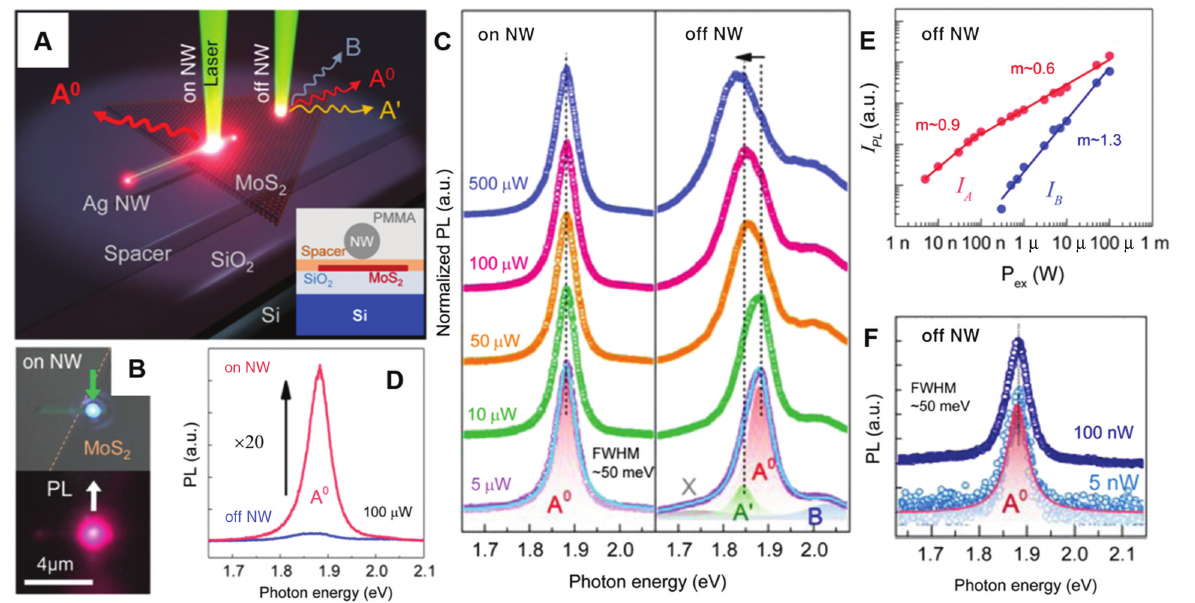
Figure 2: Typical exciton modes for monolayer MoS